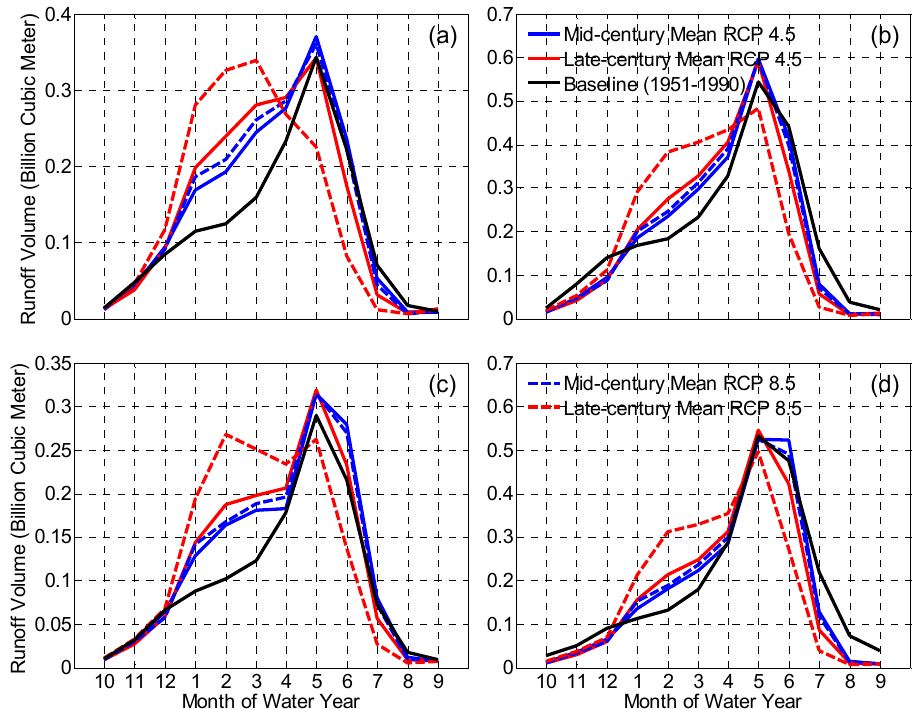
Figure A3. Monthly mean runoff projections for ( a ) Sacramento River above Bend Bridge, ( b ) Feather River, ( c ) Yuba River, and ( d ) American River under RCP 4.5 and RCP 8.5 projections, respectively.